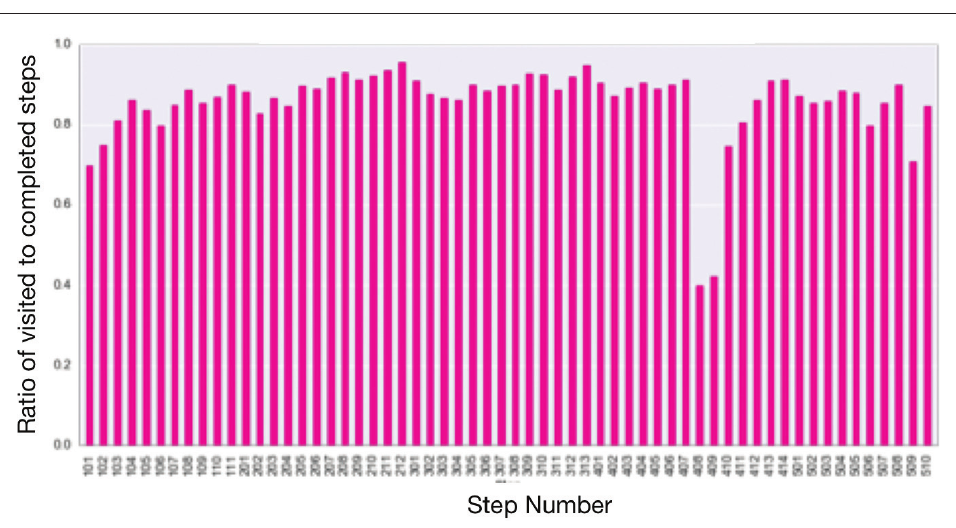
Figure 2: BLE1 Combined proportion of steps visited which were